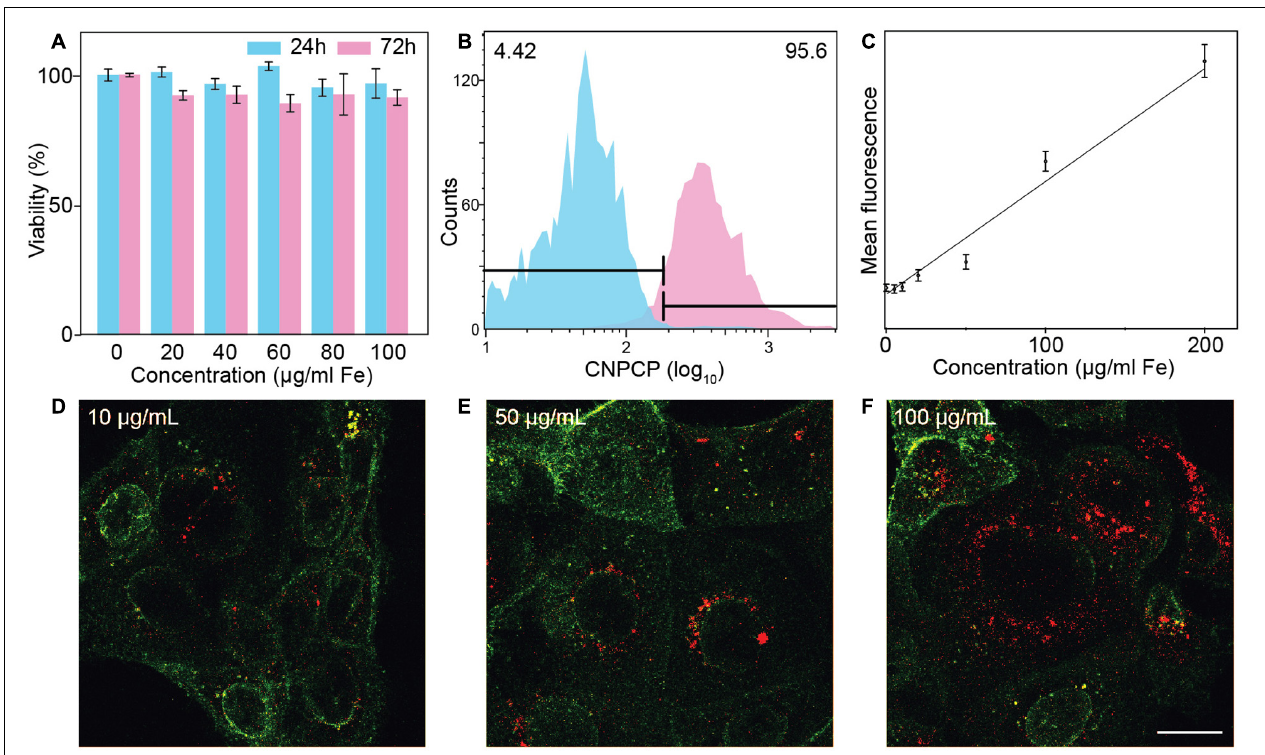
FIGURE 5 | In vitro evaluation of CNPCP as fluorescence imaging probe. (A) Cell viability of SF763 cells evaluated via alamarBlue assay. (B) Representative histogram of distribution of cells treated (pink) with CNPCP and untreated (blue) cells. (C) Comparison of mean fluorescence and nanoparticle measured through flow cytometry. (D–F) Confocal fluorescence microscopic images of SF763 cells treated with NPCPs at 10, 50, and 100 µ g/ml. WGA-AF647 membrane stain will show in green and fluorescence from CNPCP is shown in red. Scale bar = 20 µ m.